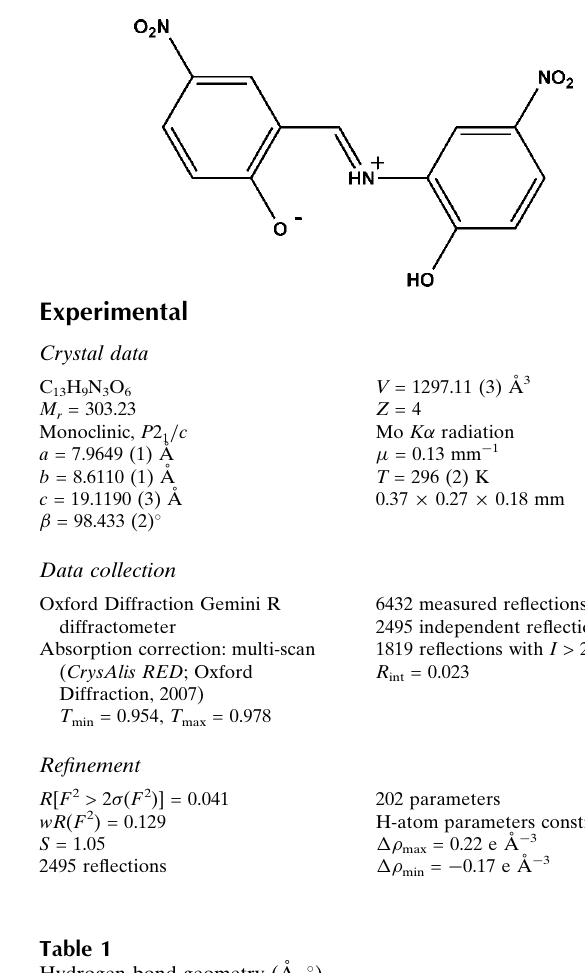
Hydrogen-bond geometry (A˚ , (cid:1) ). D —H (cid:2)(cid:2)(cid:2)